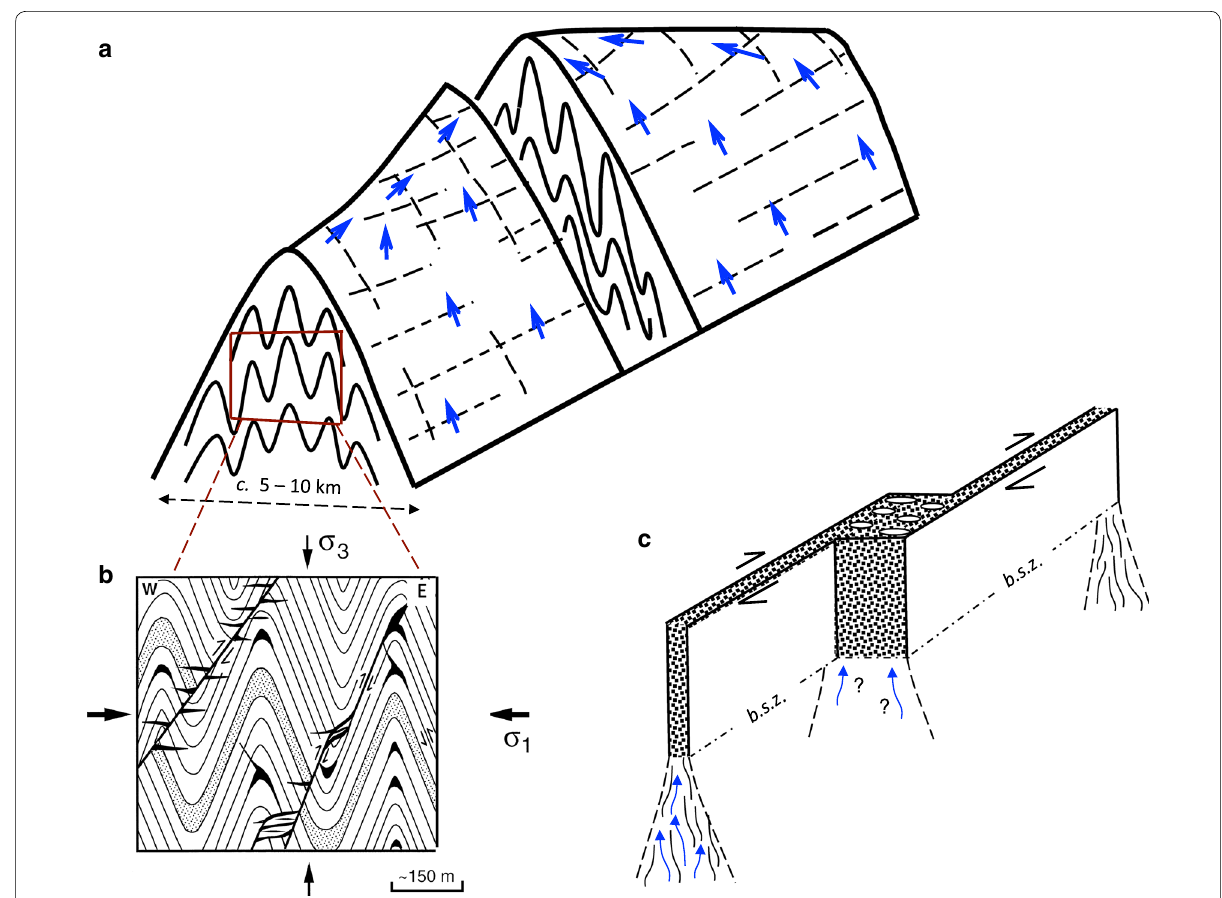
Fig. 11 a Schematic of hydrothermal fluid flow (arrows) inferred for an amplifying anticlinorial dome structure within the Upper Ordovician turbidite sequence of the Bendigo–Ballarat area of the Lachlan fold-belt of Victoria, Australia (after Cox et al. 1991; Willman 2007); b structural and inferred stress controls on Au–quartz vein systems (black) developed within similar upright fold structures in the Lachlan fold-belt (after Cox 1995; Sibson and Scott 1998; Willman 2007; Sibson 2020); c schematic of dextral strike–slip fault zone with a local dilational jog: fluid focusing occurs within ductile shear zones which flare outwards below the base of the seismogenic zone (b.s.z.) and within the enhanced permeability of the dilational stepover which acts as a pipe